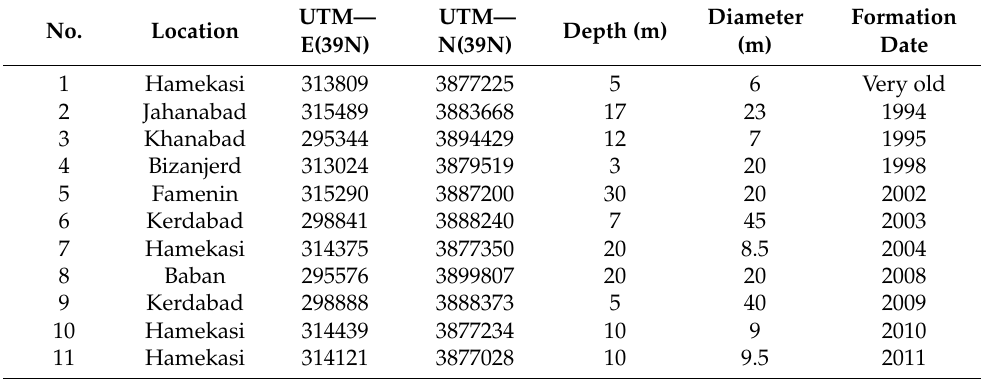
Table 1. Characteristics of significant sinkholes in Hamedan state [49].